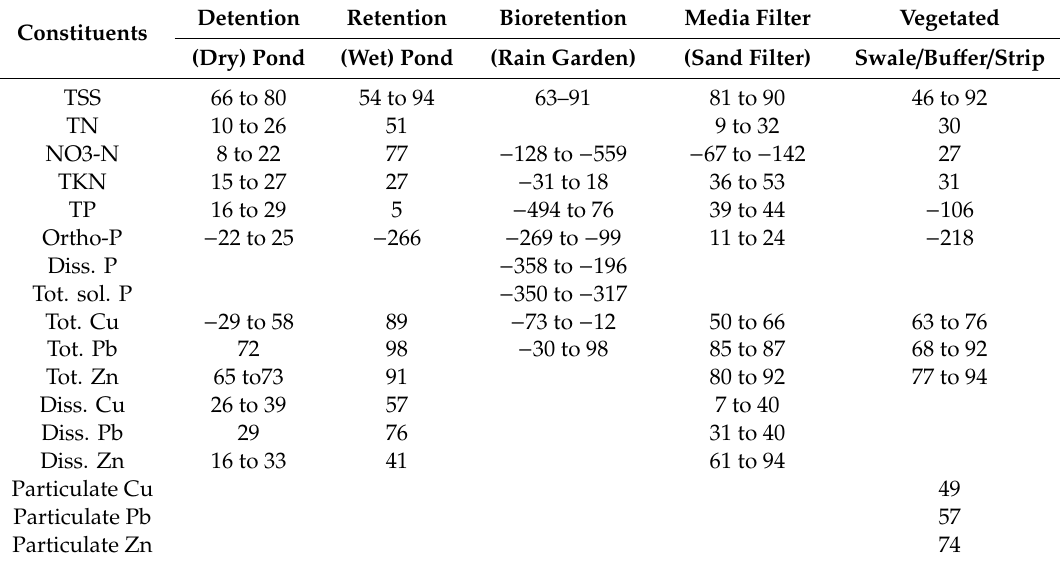
Table 3. Summary of pollutant removal e ffi ciencies from various GI practices